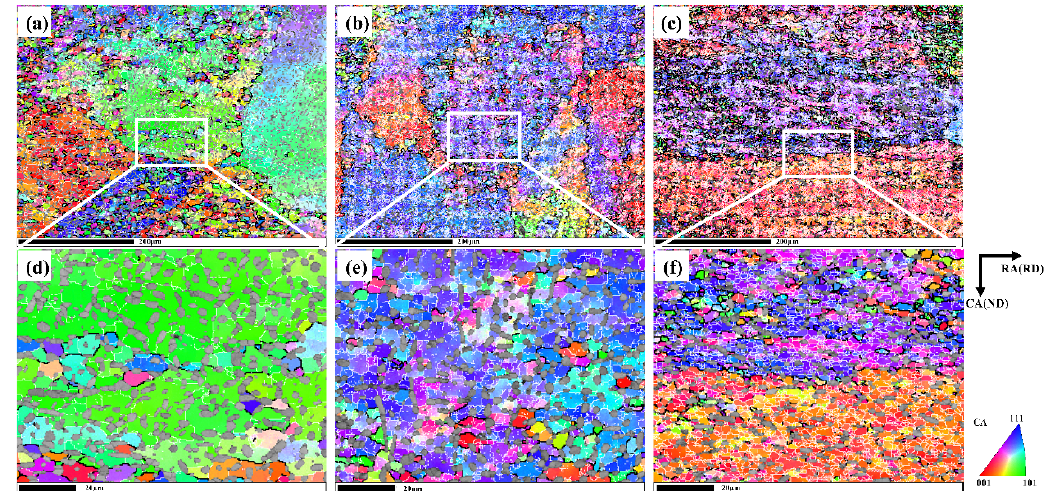
Figure 5. The IPF maps of the β phase in TB6 alloy deformed at 740 °C and varied strain rates: ( a , d ) 0.0001 s − 1 ; ( b , e ) 0.01 s − 1 ; ( c , f ) 1 s − 1 .